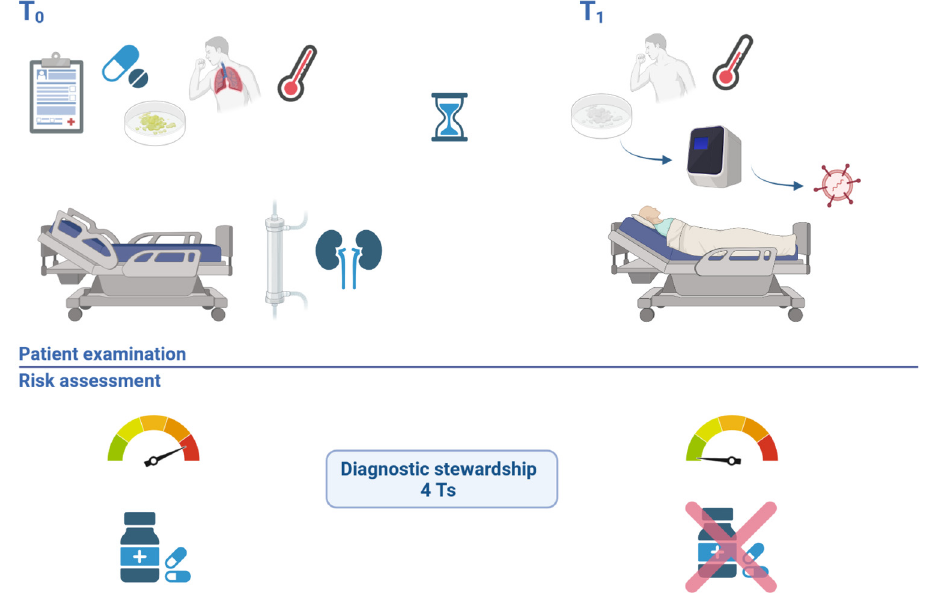
Figure 1. Case evaluation timeline–patient 1. T 0 illustrates the initial risk assessment, in the absence of the patient, highlighting the high risk of a bacterial infection with a multidrug-resistant organisms in a patient with multiple comorbidities, immunosuppression, high fever, productive cough and recent antibiotic use. Diagnostic stewardship was applied (4 Ts): based on the right molecular Test, from the right Type of sample, collected at the right Time, Treatment was revised. T 1 illustrates the new risk assessment performed after examining the patient, noting a good clinical state and ordering a molecular test that ruled out a bacterial infection, while confirming the viral etiology of pneumonia, allowing the stop of empirical wide spectrum antibiotherapy.